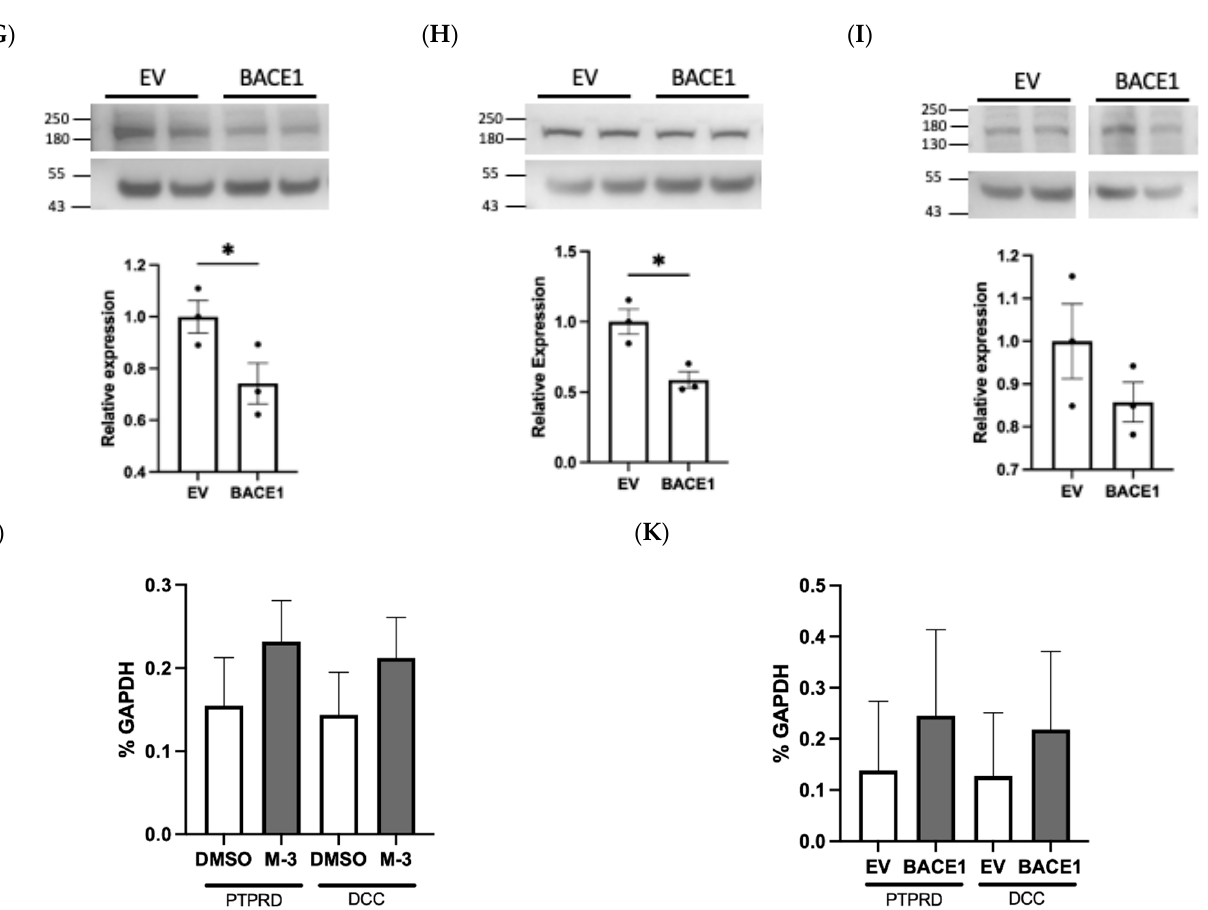
Figure 7. Experimental validation of NCAM1, PTPRD, and DCC as BACE1 substrates. Western blots were performed on protein lysates from BACE1 knockout (KO) and wildtype (WT) brain endothelial cells (BECs) or hCMEC/D3 treated with M-3 or transfected with BACE1. Relative protein expression of full length NCAM1 ( A , D , G ), PTPRD ( B , E , H ), and DCC ( C , F , I ) after normalisation to beta actin. PTPRD and DCC gene expression ( J , K ) in hCMEC/D3. N = 3 per group, * denotes p < 0.05.